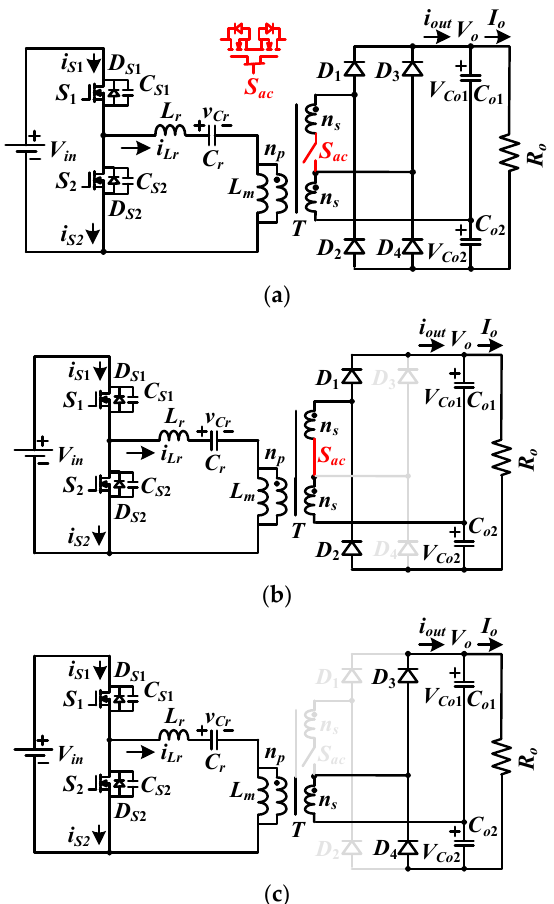
Figure 2. Circuit structure of ( a ) the presented converter ( b ) under low-voltage operation ( S ac on) and ( c ) under high-voltage operation ( S ac off).